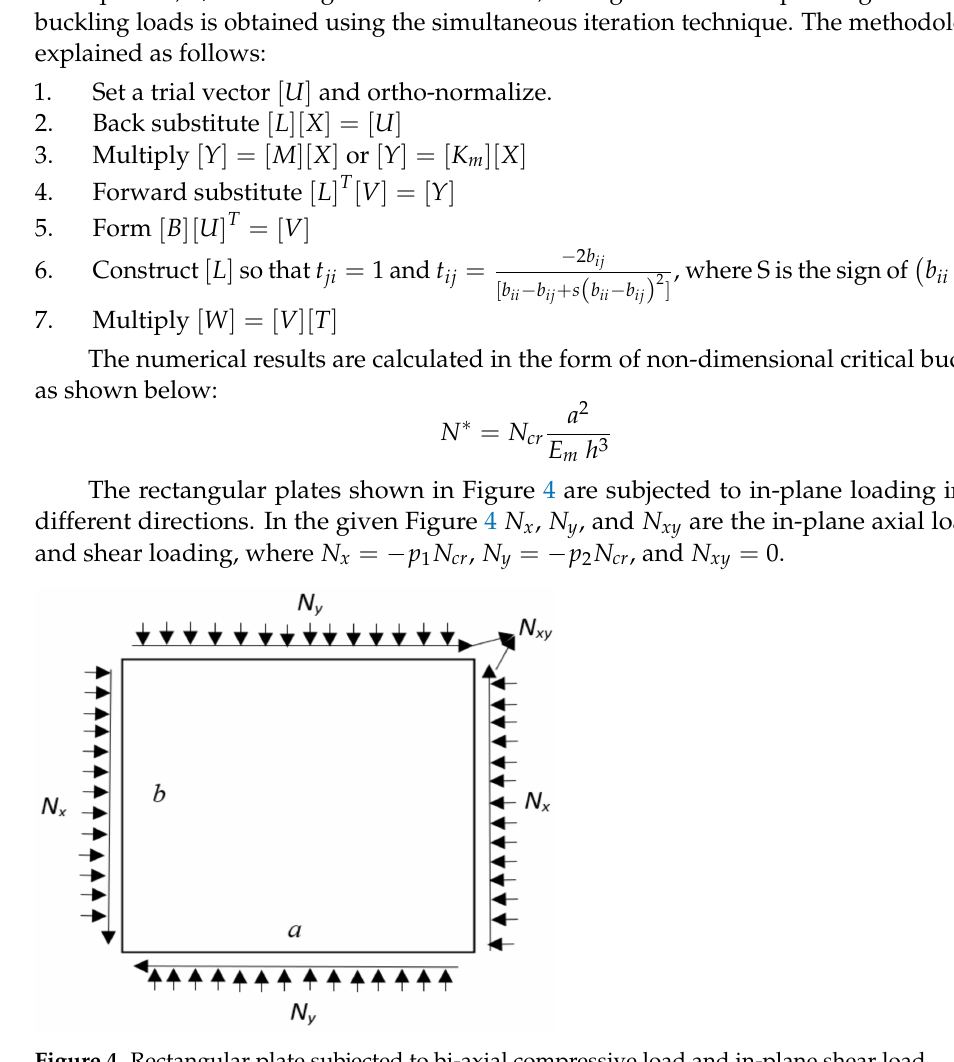
Figure 4. Rectangular plate subjected to bi-axial compressive load and in-plane shear load. The different loading conditions are Uniaxial compression: p 1 = − 1 and p 2 = 0 Biaxial compression: p 1 = − 1 and p 2 = −